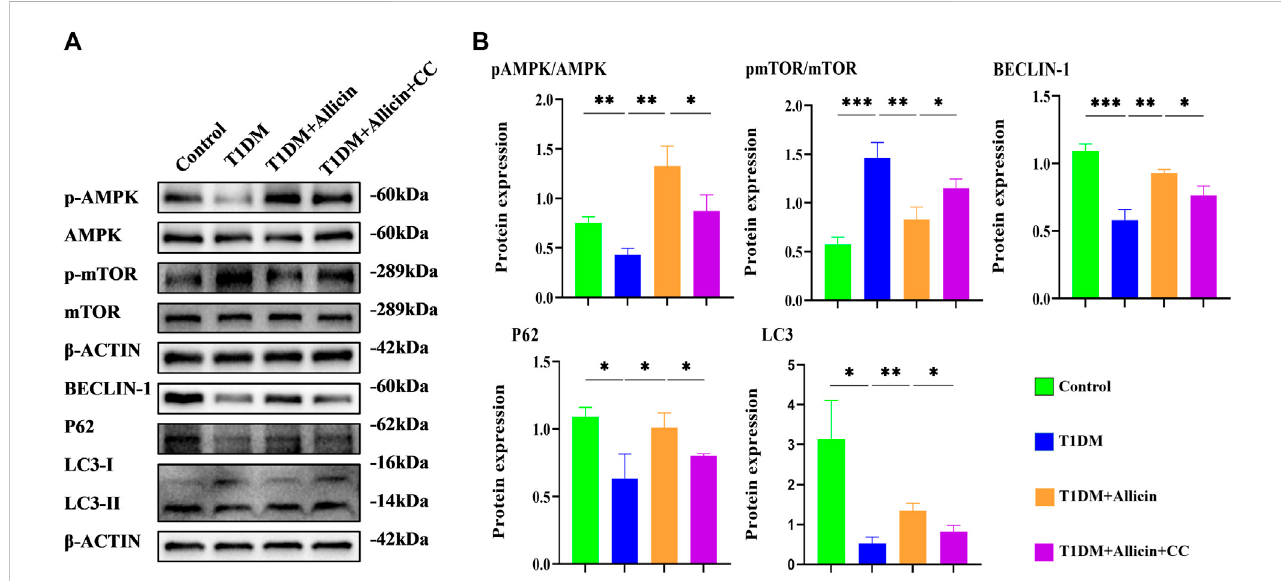
FIGURE 7 Allicin mediated pancreatic β cell Min6 autophagy through activating AMPK/mTOR in vitro . (A) Western blot gel images of proteins in AMPK/mTOR- mediatedautophagy fl uxpathway invitro . (B) Thebargraphsrepresentthequanti fi cationofproteinlevelsineachgroup( n =3).Mean±SD. *p < .05, **p < .01, ***p < .001 indicate signi fi cant